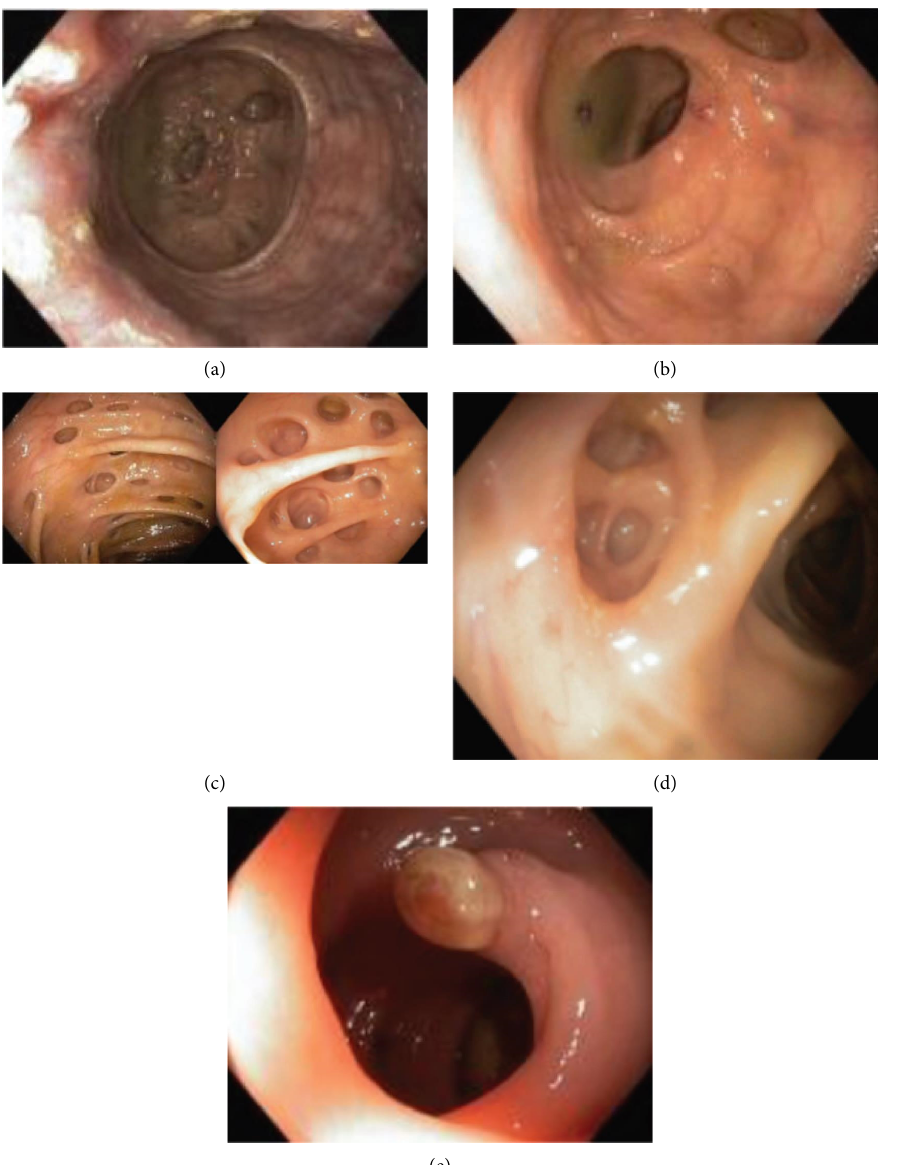
Figure 2: Pancolonic diverticulosis in a 50-year-old African Caribbean patient consisting of both a large rectal diverticulum (a), rare diverticula in the left-side (b), multiple (c) and deep second and third generation diverticula (d) in the right-side colon and an inverted diverticulum